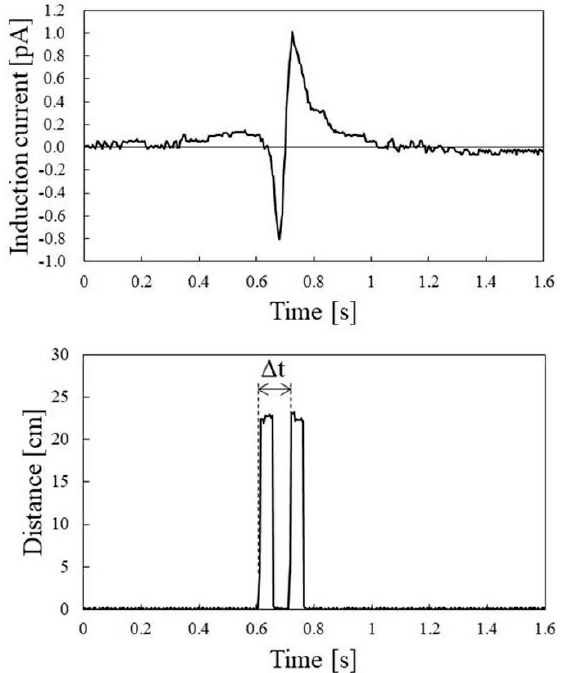
Figure 7. Electrostatic induction current trace induced by palm movement ( upper panel ) and ranging trace obtained by ranging sensor module ( lower panel ) .